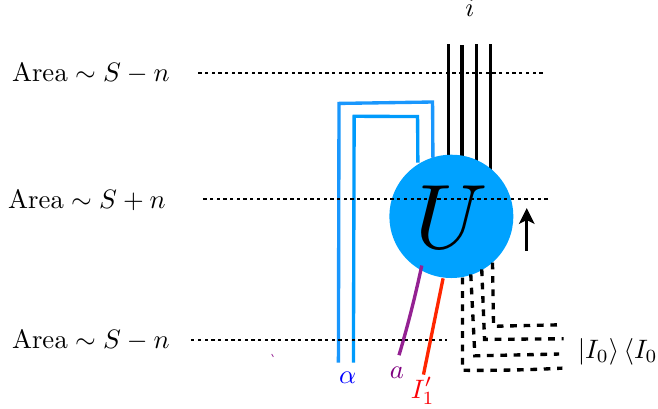
Figure 5 . Cross-sectional areas of the tensor